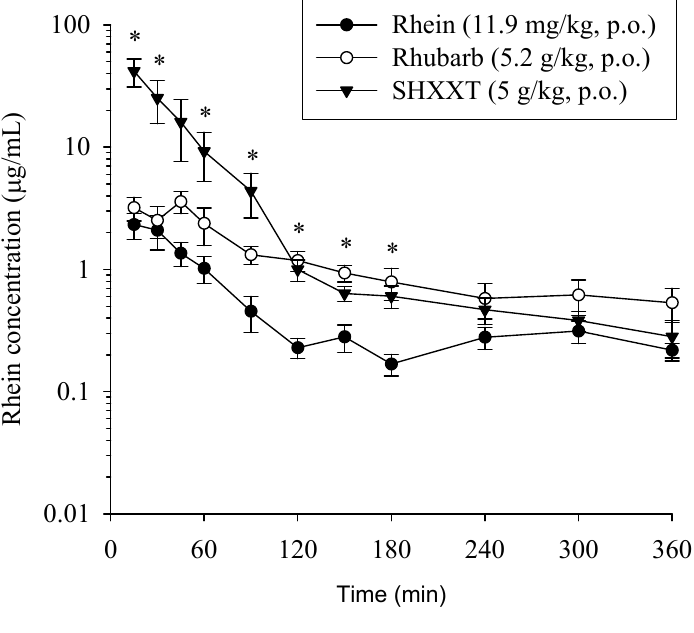
Figure 4. Mean plasma concentration-time profile of rhein after oral dosed with a single Chinese herb (5.2 g/kg, ○ ), Chinese herbal formulae (5 g/kg, ▼ ,) or rhein (11.9 mg/kg, ● ). Each point represents mean ± SEM ( n = 6). * significantly different from rhein alone at p <